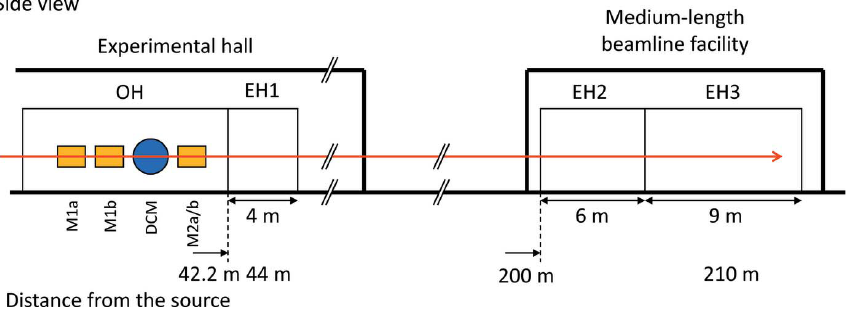
Figure 1 Schematic of the beamline with the optics hutch (OH) and the experimental hutches (EH1, EH2 and EH3). The main optical components, that is, the multilayer mirrors (M1a, M1b and M2a/b) and DCM, are located in the